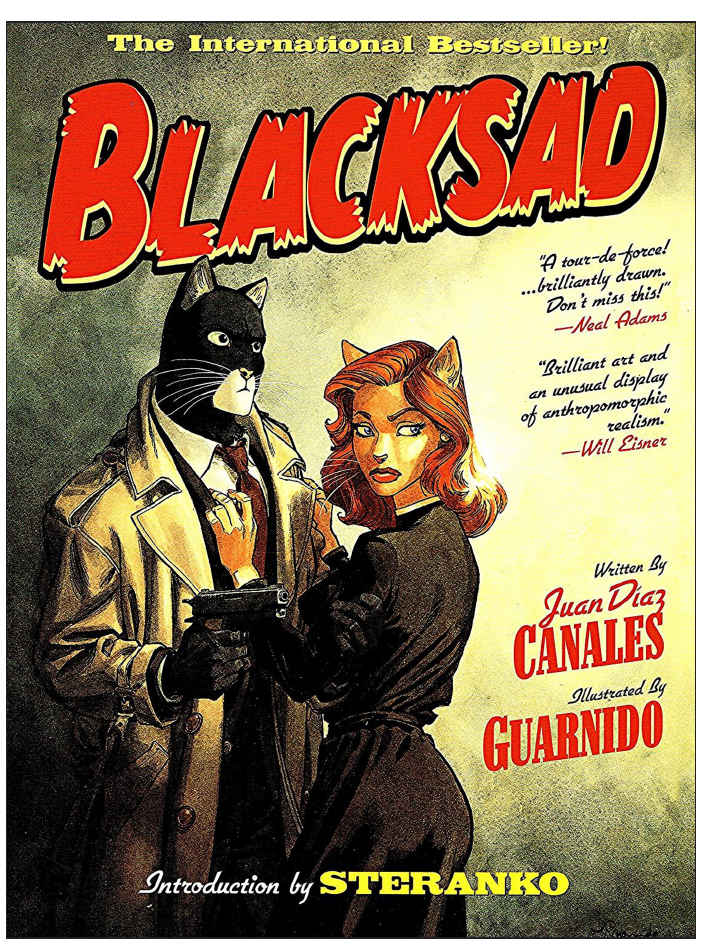
Figure 1: Juan Díaz Canales and Juanjo Guarnido, Blacksad: Somewhere within the Shadows 2000, Dargaud,